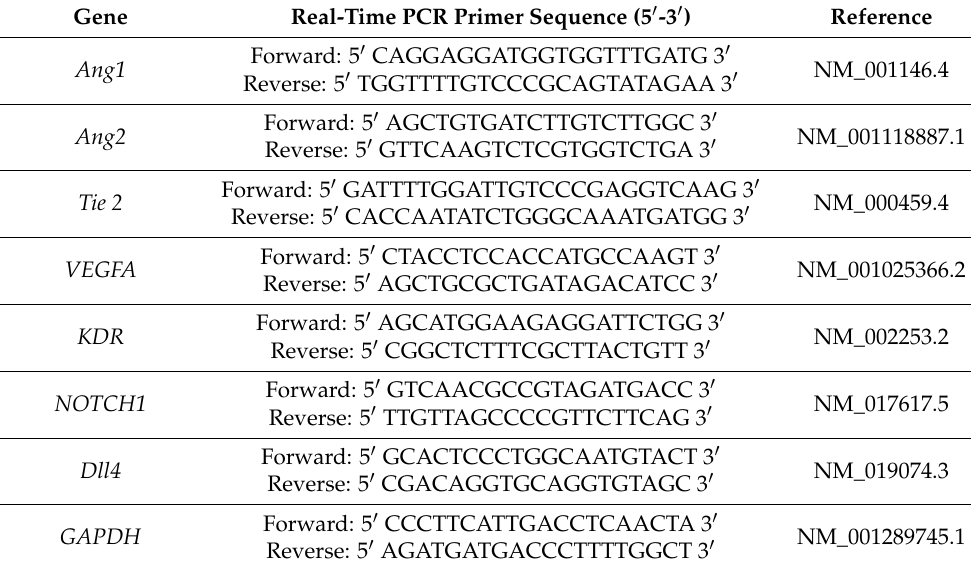
Table 1. The real-time PCR primer